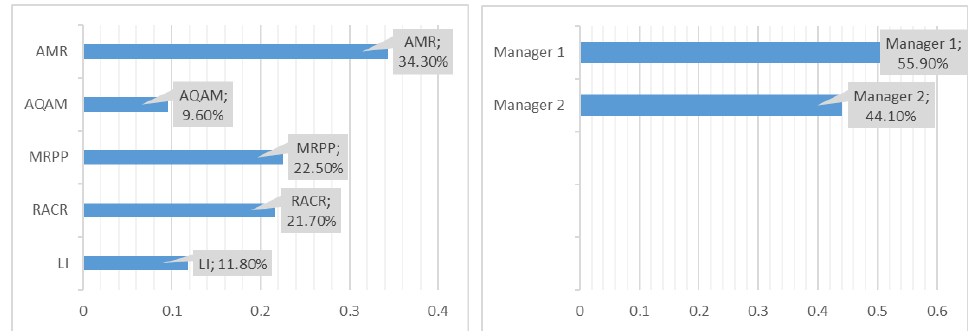
Figure 6. Scenario 4 (own processing).